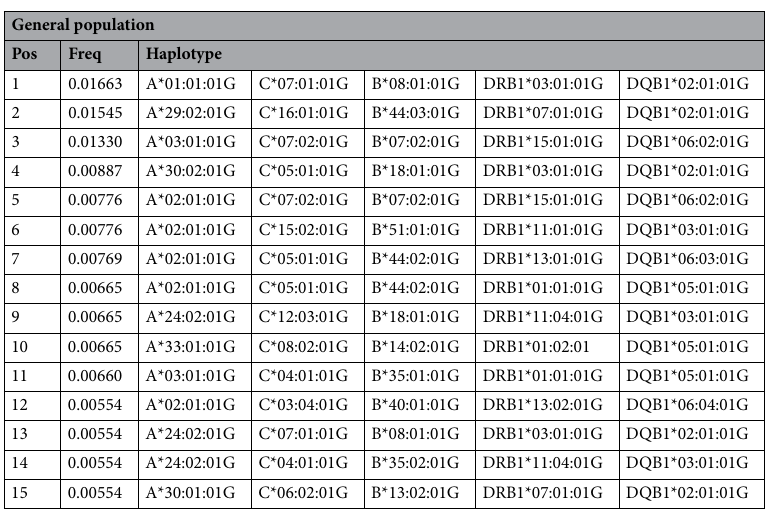
Table 5. List of the more frequent estimated HLA-A~B~C~DRB1~DQB1 haplotypes for the general